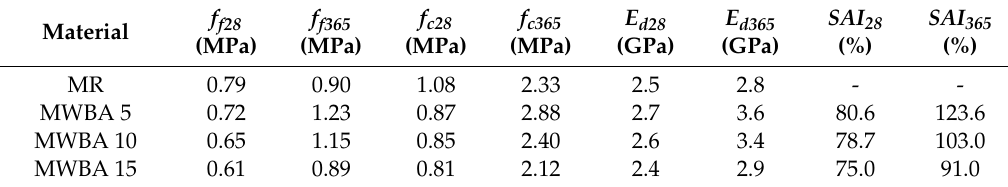
Table 10. Mechanical parameters of studied mortars. SAI: strength activity index.